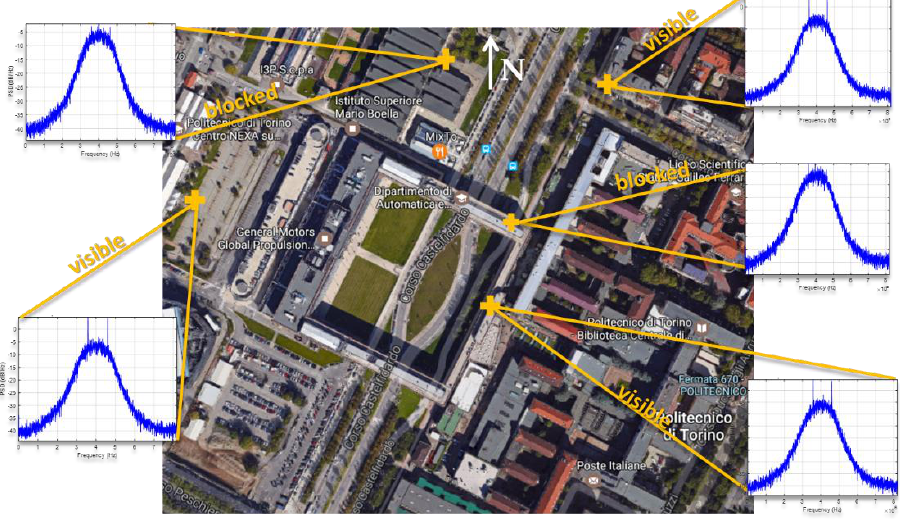
Figure 11. The spectrum observed in the dynamic test.